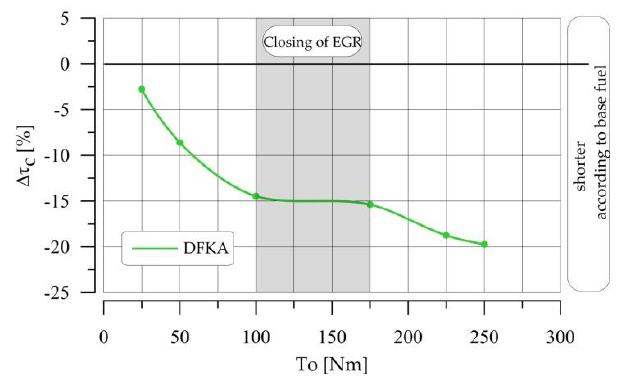
Fig. 14. Percentage difference in auto-ignition delay (Δτ c ) of the VW 1.9 TDI engine fueled with test fuel in relation to the base fuel [7] It can be seen from the data in Fig. 15 that the end of the test fuel (with nitrON ® addition) burn is earlier in compari- son to the base fuel under high engine loads. The earlier end of combustion reduces the heat loss carried out with the exhaust gas, which translates into an increase in thermal efficiency (η ) for the test fuel. t